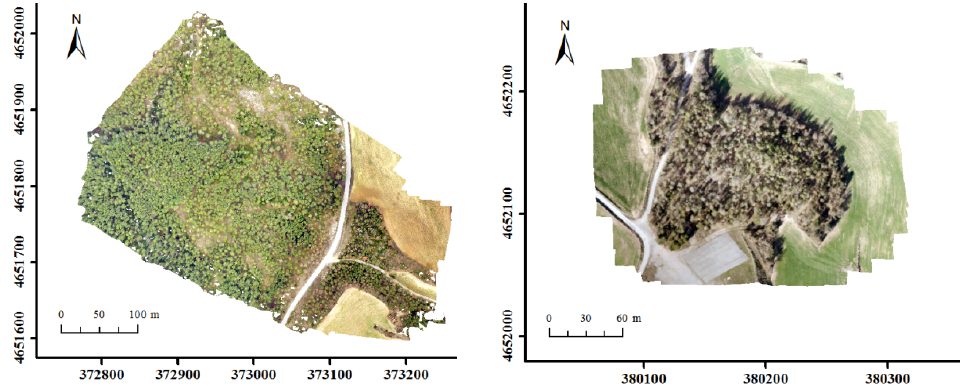
Figure 2. Orthomosaics of the two study sites: Torregassa ( left ) and Bosquet ( right ) (Catalonia, Spain).